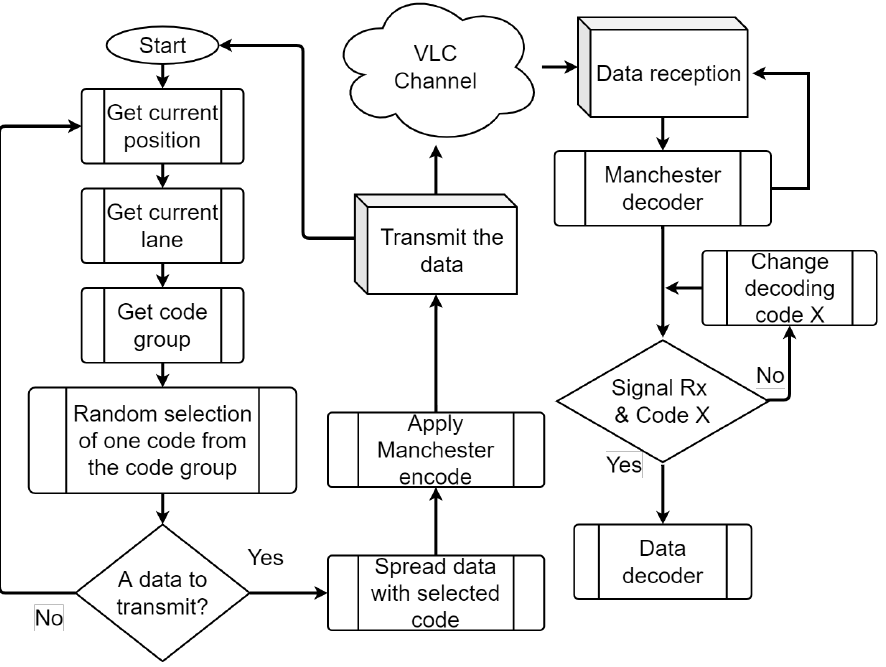
Figure 8. Flowchart of the proposed CDMA MAC